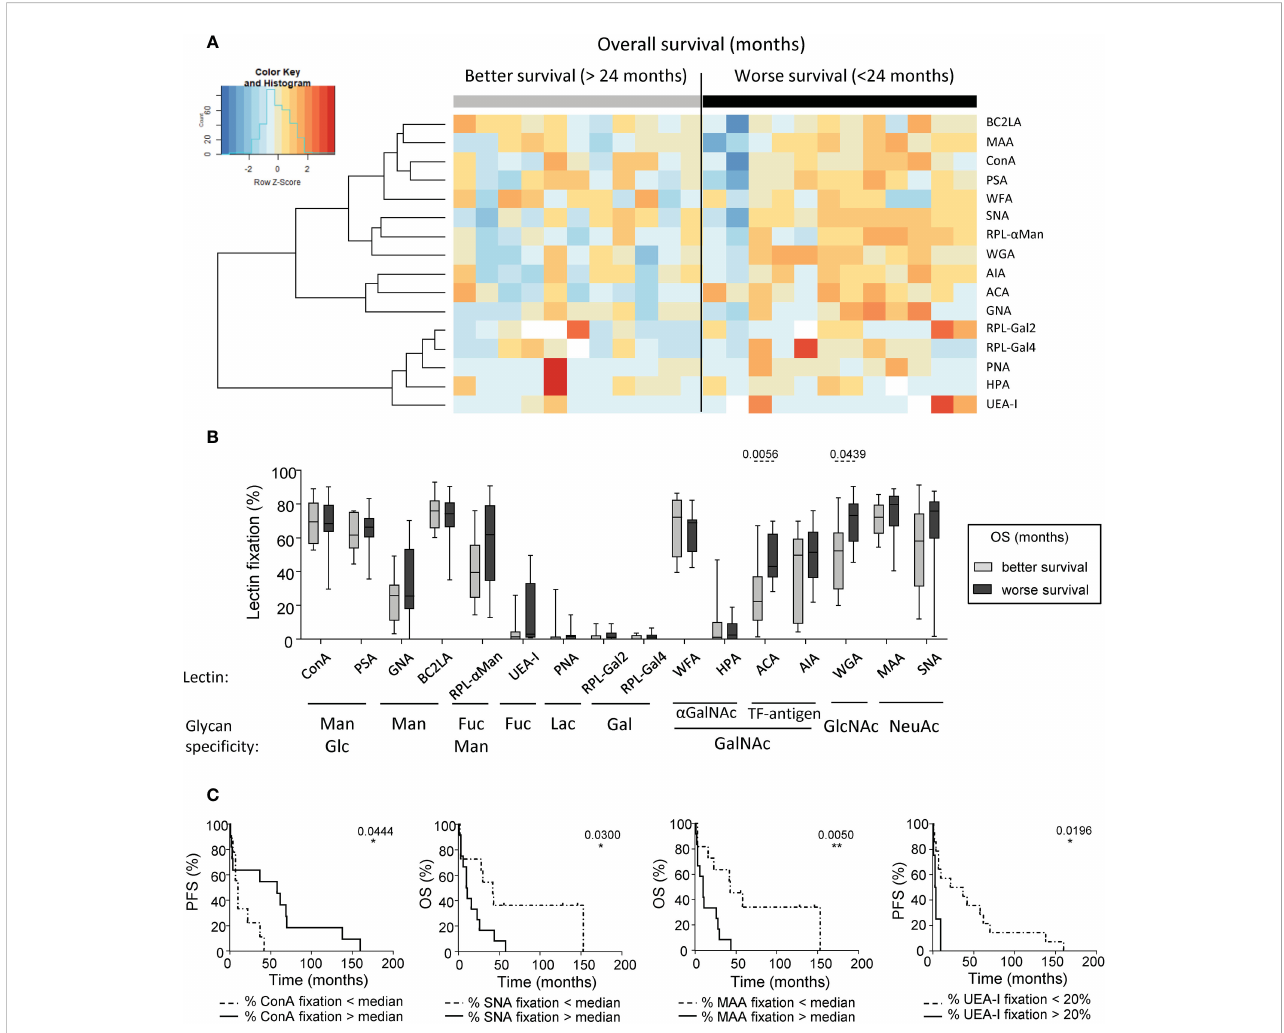
FIGURE 3 Differences of glycan expression in the tumor glyco-code were linked to the clinical outcome of melanoma patients. GLYcoPROFILE ™ (lectin arrays from GLYcoDiag) were performed on tumor cell lines derived from melanoma patients (n = 23). Samples were then separated given patient ’ s clinical data. (A) Heat map based on frequencies of 16 different lectins fi xation (binding different glycans) on tumor cell lines derived from patients with better (n =11) or worse (n = 12) overall survival (OS) from sampling time (separation based on the median OS of 24 months). (B) Frequencies of lectin fi xation (indicators of levels of glycan expression) by tumor cells derived from patients with better (n = 9 to 11) or worse (n = 10 to 12) overall survival (from sampling time). Results are expressed as percentages of lectin binding within each group. Interleaved box and whiskers representation plotting from minimum to maximum. P -values were calculated using Mann-Whitney non-parametric U-test. (C) Comparative PFS (from diagnostic time) and OS (from sampling time) of patients with tumor cell lines displaying low or high fi xation of ConA (n=9-11 patients/group), SNA (n=11-12 patients/group), MAA (n=11-12 patients/group), or UEA-I (n = 4-14 patients/group). Groups were separated using median percentage of fi xation of ConA (69.48%), SNA (70.46%) or MAA (75.5%), and a threshold of 20% for UEA-I fi xation. Comparison using Log-rank test. *P-value ≤ 0.05, **P-value ≤